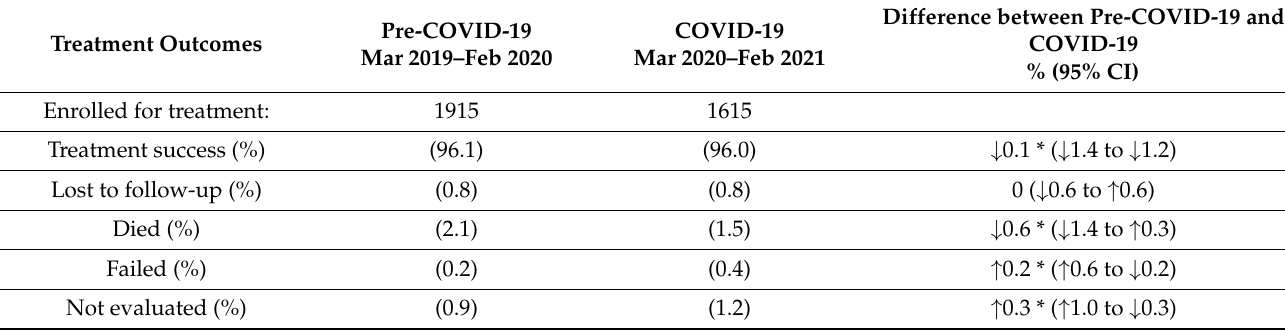
Table 2. Treatment outcomes of patients enrolled in TB treatment in eight selected health facilities in Malawi, during pre-COVID-19 and COVID-19 periods.